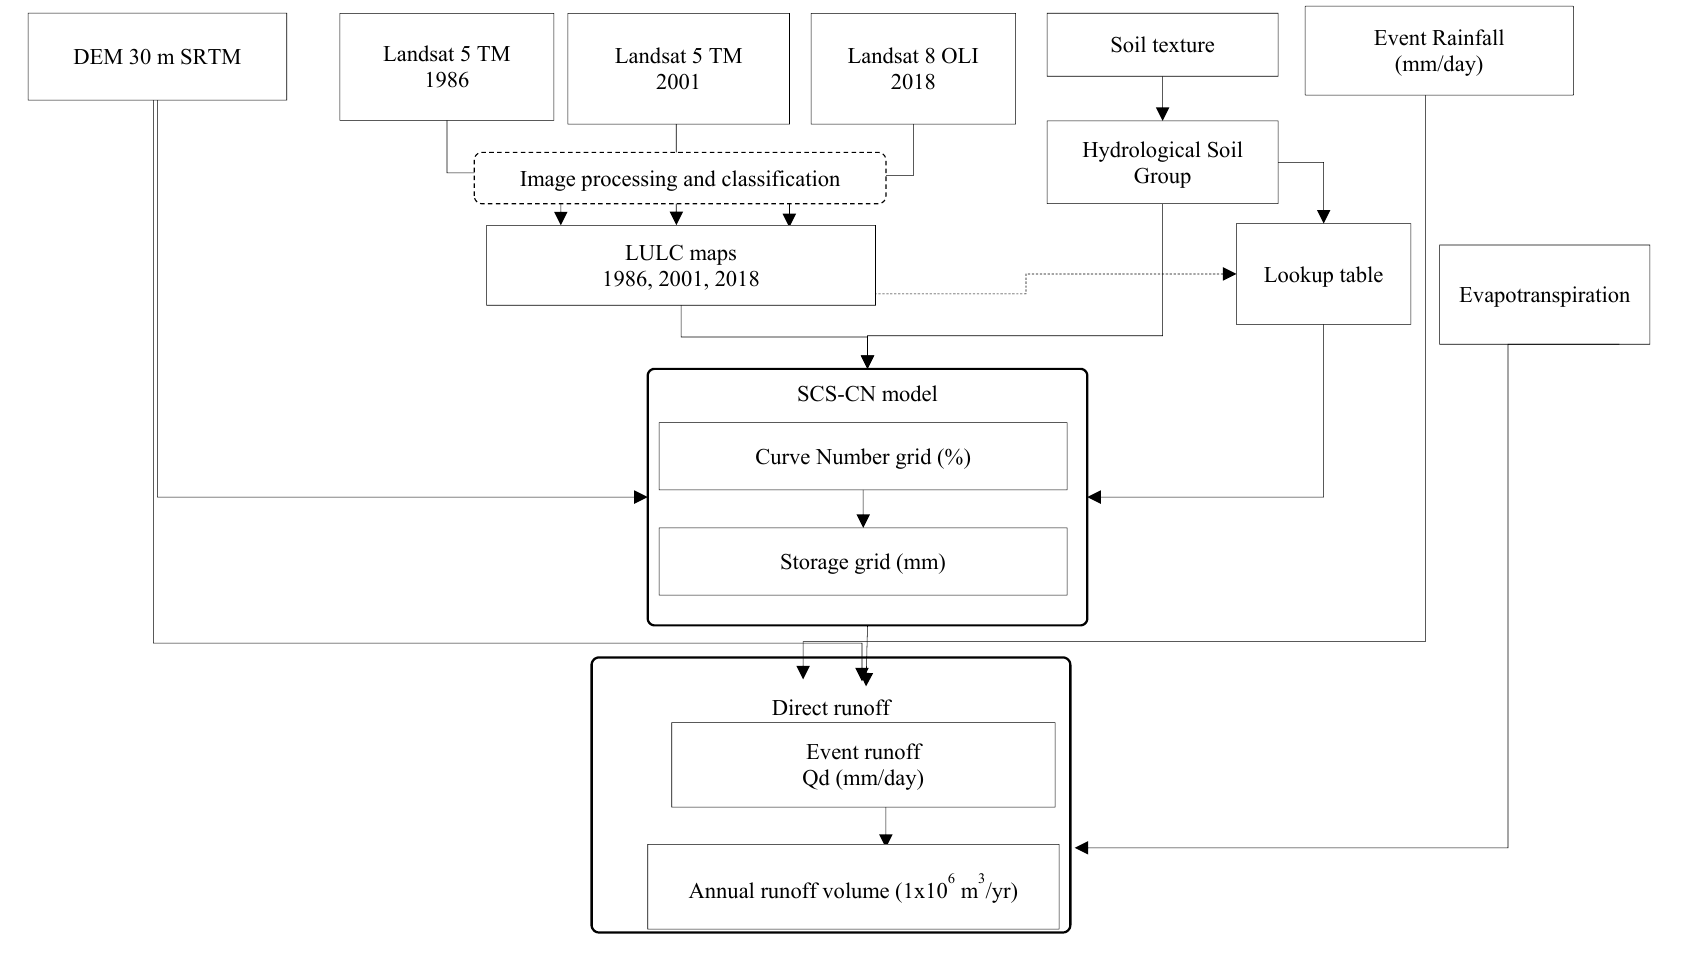
Figure 2. Conceptual